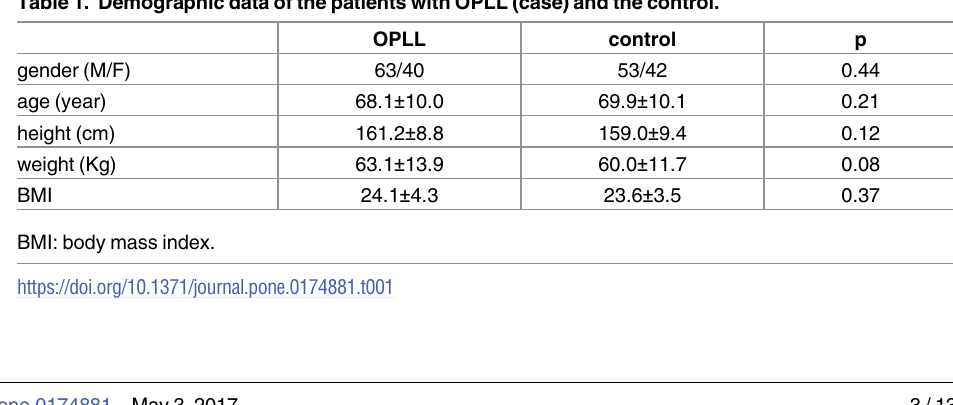
Table 1. Demographic data of the patients with OPLL (case) and the control. OPLL control p gender (M/F) 63/40 53/42 0.44